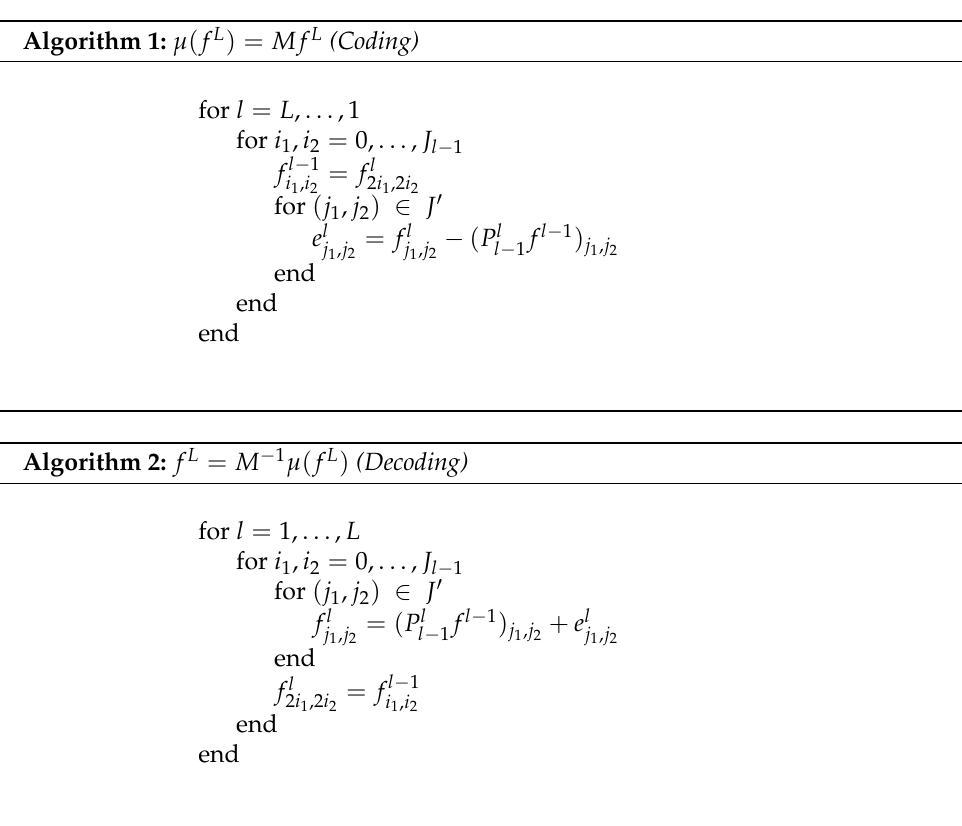
Algorithm 1: µ ( f L ) = M f L (Coding)